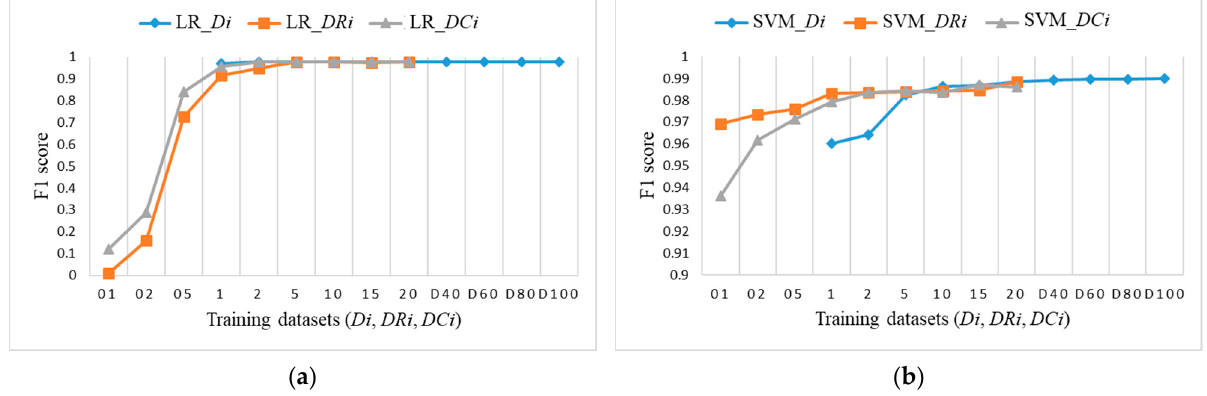
Figure 17. F1 score on test dataset for training datasets Di , DRi , DCi : ( a ) LR; ( b ) SVM.